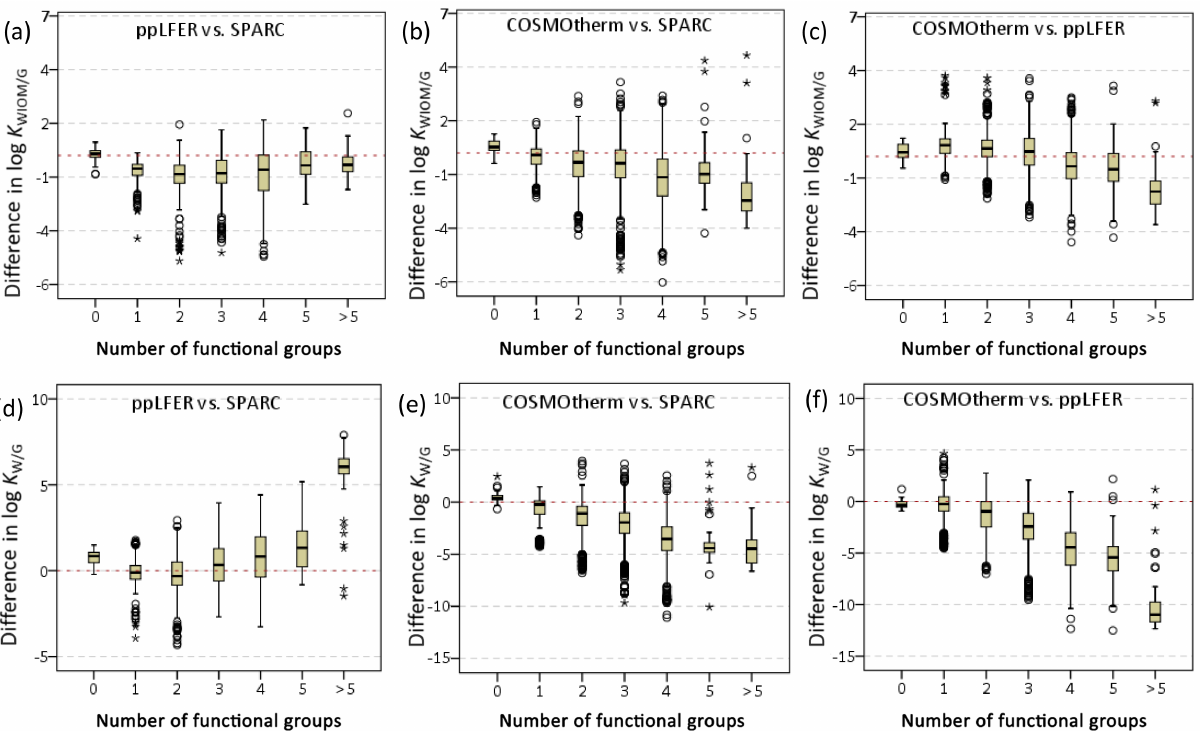
Figure 2. Box plot of difference in SPARC, ABSOLV–ppLFER, and COSMOtherm predictions for compounds with different number of functional groups. The line inside each box shows the median difference for log K WIOM/G or log K W/G for different categories of compounds. The marker circle and star indicate possible outliers and extreme values, respectively. Note the different scales for different